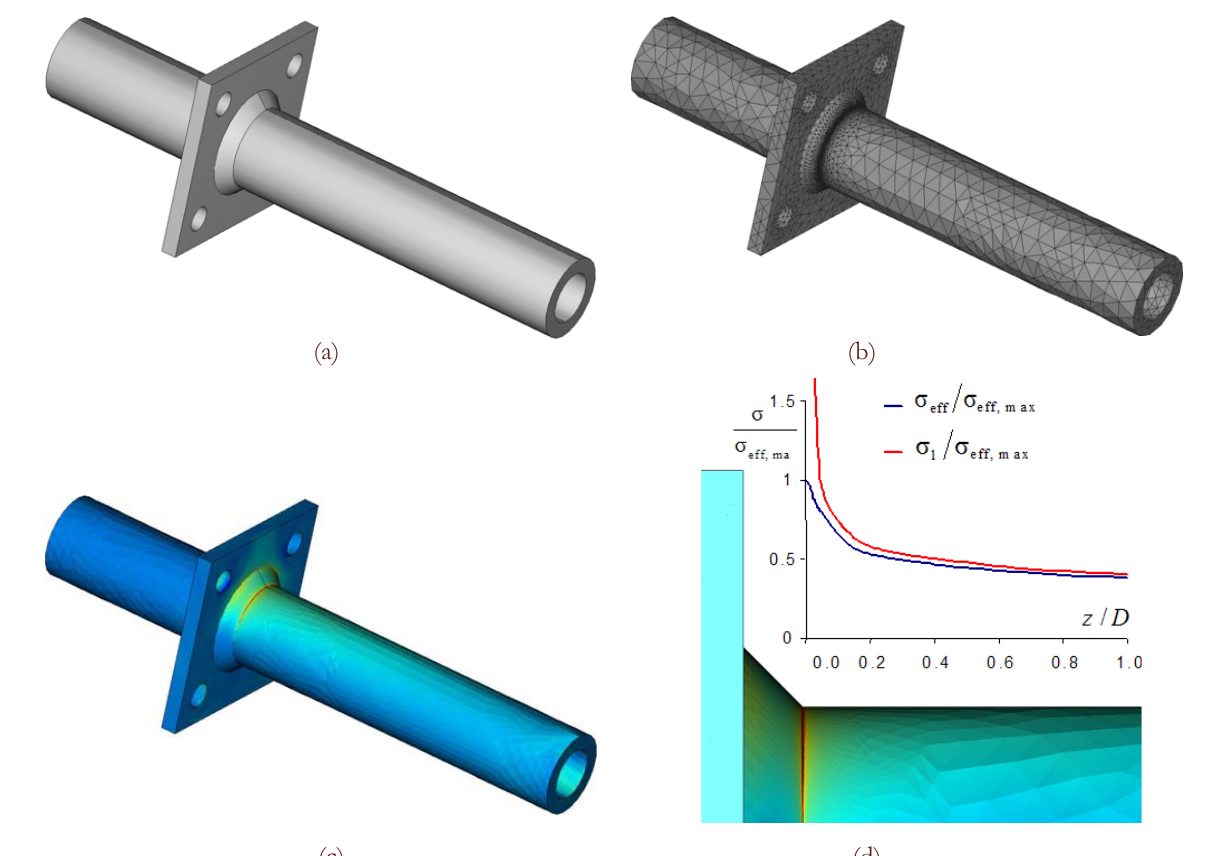
Figura 4: Esempio di mesh e soluzione ottenuta in automatico partendo dalla geometria del giunto. a) Modello CAD di un giunto a cordone portante sollecitato a flesso-torsione. b) Mesh ad elementi tetraedrici utilizzata per analizzare il giunto; c) Mappatura a scale di colori della tensione efficace (massima tensione principale come tensione equivalente non locale; c=0.2 mm); d) Andamento della tensione principale massima  1 e della tensione efficace  eff lungo una generatrice esterna del cilindro. I valori sono normalizzati rispetto al valore massimo della tensione efficace  eff, max e sono rappresentati in funzione della distanza z dal piede del cordone normalizzata rispetto al diametro esterno del tubo